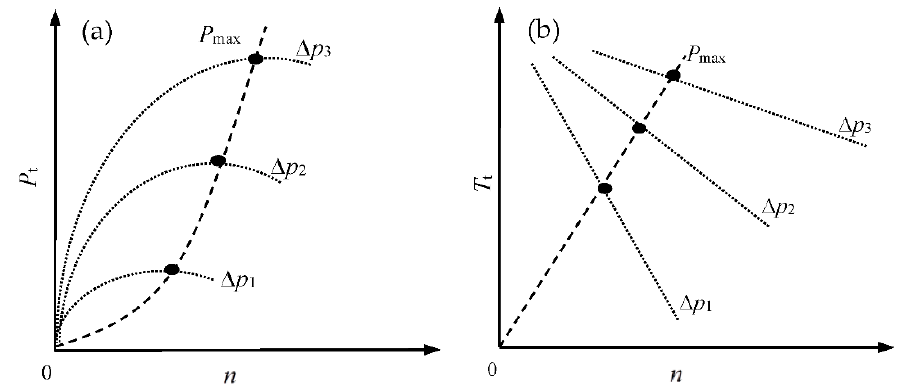
Figure 5. PEU control curves showing characteristics of: ( a ) power P ( n ) and ( b ) PMSG torque T ( n ) for different values of I limit s and I limit DC